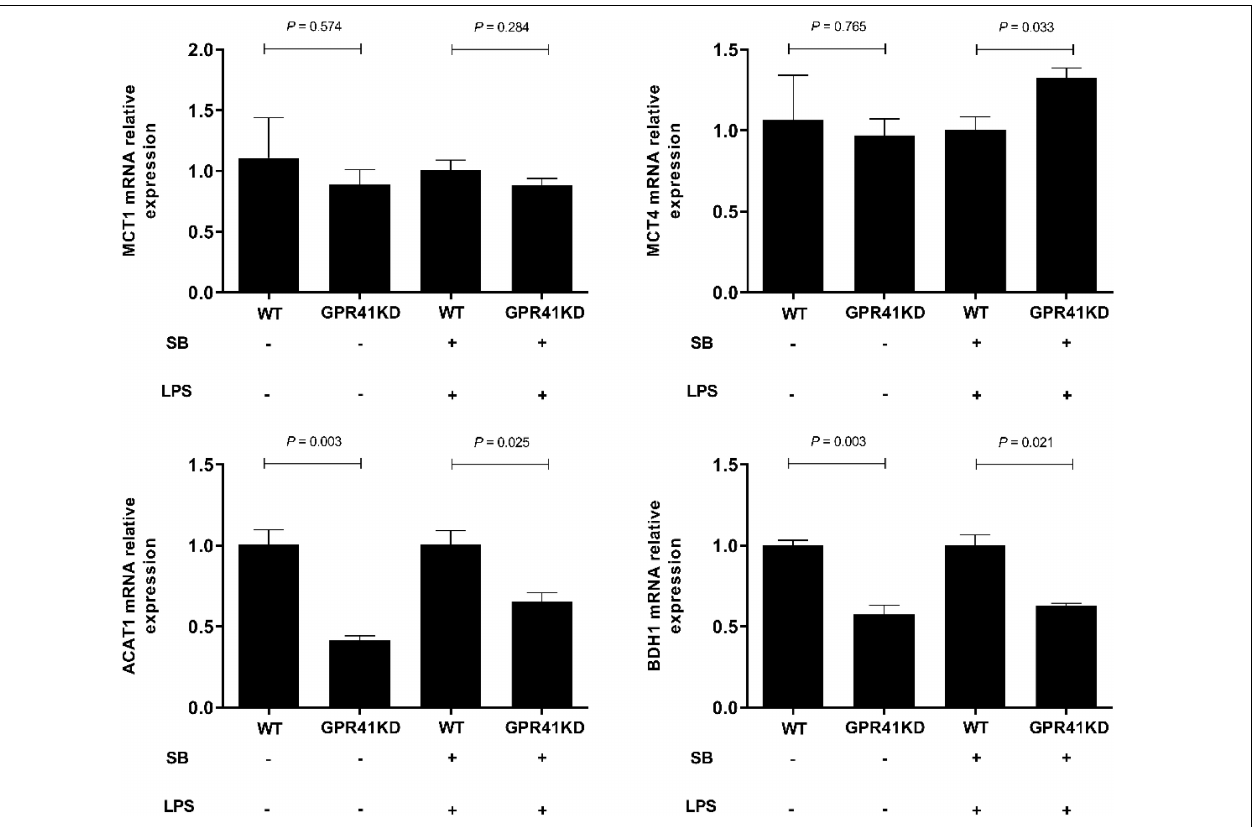
FIGURE 9 | The effect of GPR41 on the expression of genes involved in SB uptake and metabolism. Generation of GPR41-knockdown (GPR41KD) BREC cell lines using the CRISPR/Cas9 system. Pretreatment with SB in BRECs and BRECEs-GPR41KD for 18 h, then treated with 4 µ g/mL LPS for 6 h. After incubation, cells were analyzed by qRT-PCR. The values are shown as mean ± SEM ( n =